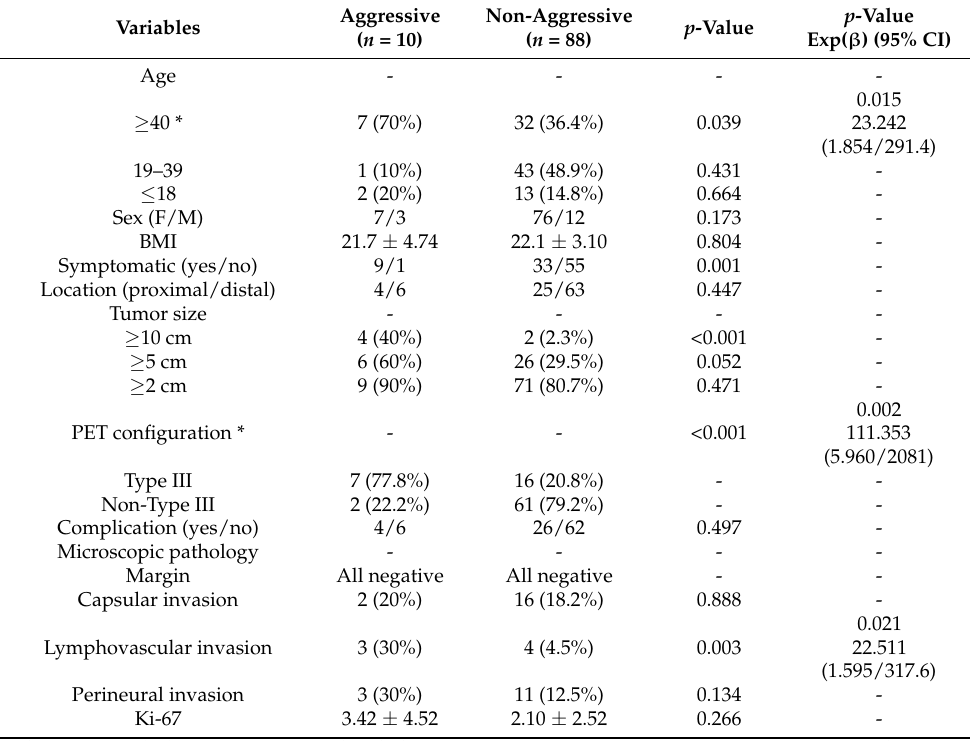
Table 5. Characteristics of patients with aggressive and non-aggressive solid pseudopapillary